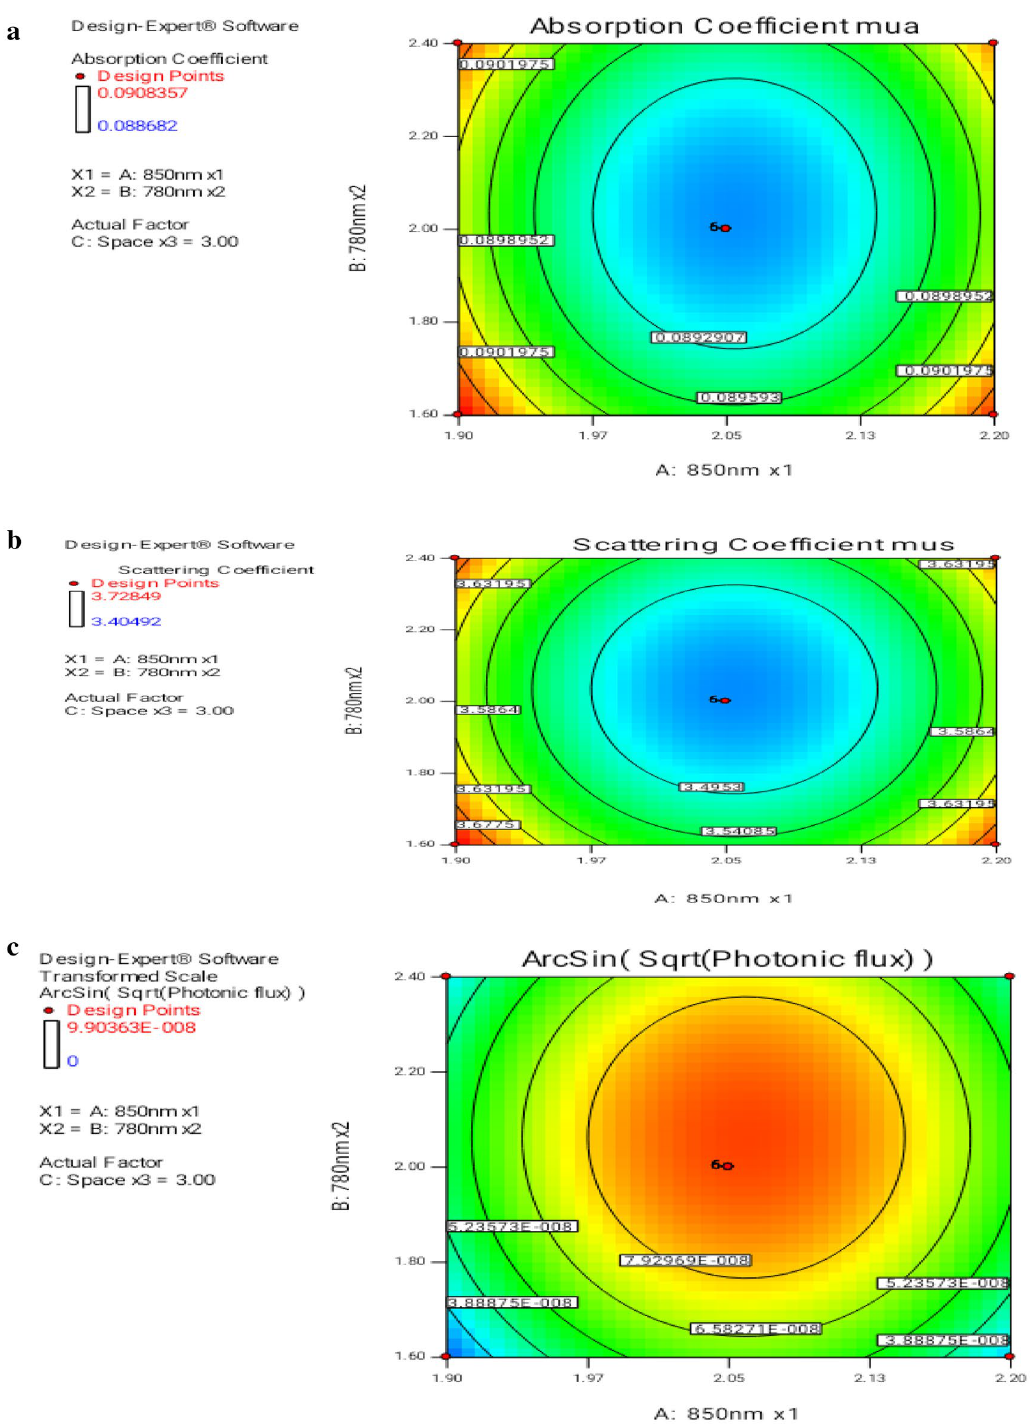
Figure 6. ( a ) Contour plot of two-factor interaction for mua—2D design produces mua response on variation in numeric input elements. ( b ) Contour plot of two-factor interaction for mus—2D design produces mus response on variation in numeric input factors. ( c ) Contour plot of two-factor interaction for phi—2D design produces phi response on variation in numeric input